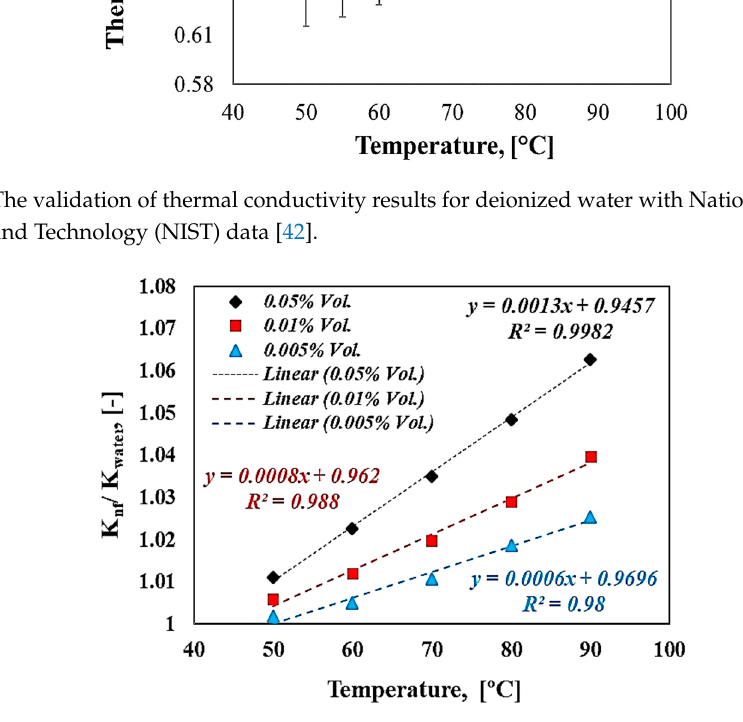
Figure 9. Boiling curves for water and WO 3 -based water nanofluids at different volume concentrations. Figure 10 shows the relationship between the pool boiling heat transfer coefficient and the applied heat flux for both deionized water and nanofluids. It can be seen that the pool boiling heat